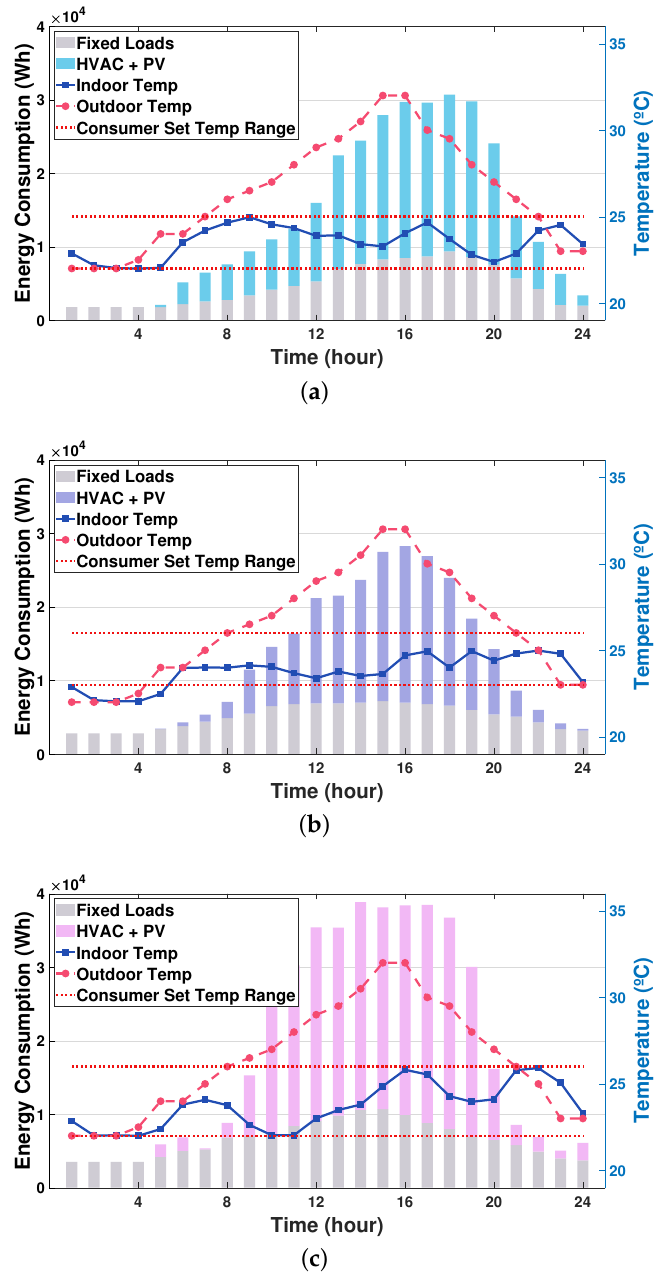
Figure 8. Sum of scheduled energy consumption for HVAC ( E HVAC ( a ) building1; ( b ) building2; and ( c )